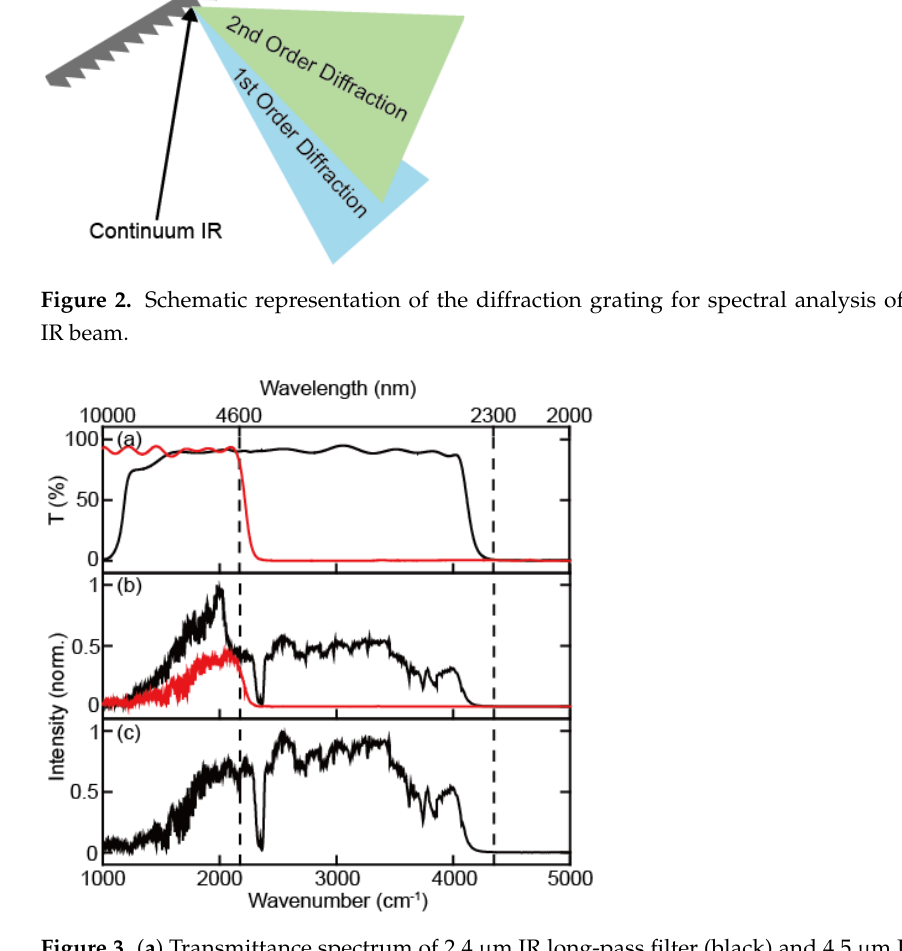
Figure 4. ( a ) The IR absorption spectra of water:benzonitrile (=1:1, volume ratio) solution measured using our continuum IR pulse obtained with a monochromator and a 2.4 μm IR long-pass filter (black) or 4.5 μm IR long -pass filter (red). ( b ) Comparison between the FTIR absorption spectrum (black) and that obtained with a continuum IR pulse (red).